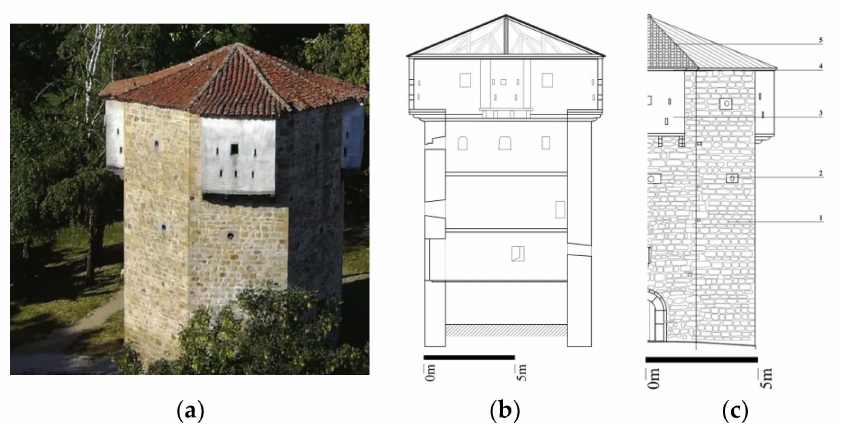
Figure 20. Tower Motrilja. ( a ) On-site aerial view (Photo source: private archive of Vladan Vidosavl- jevi´c). ( b ) Cross-section of the tower. ( c ) Detail of the materialization of the façade: 1—limestone stack; 2—circular loopholes; 3—brickworks; 4—profiled roof cornice; 5—roof tiles stack (Drawings: Lejla